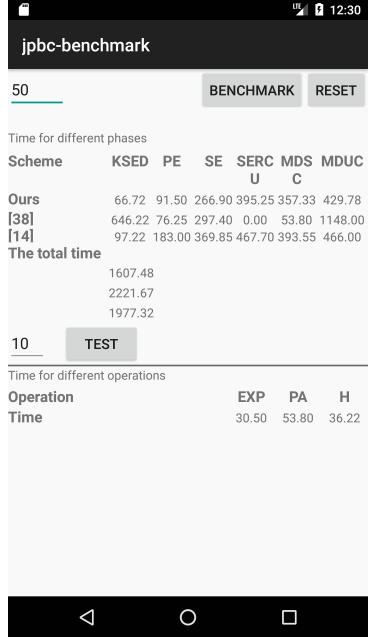
Figure 5. The computational cost comparision in different phases.